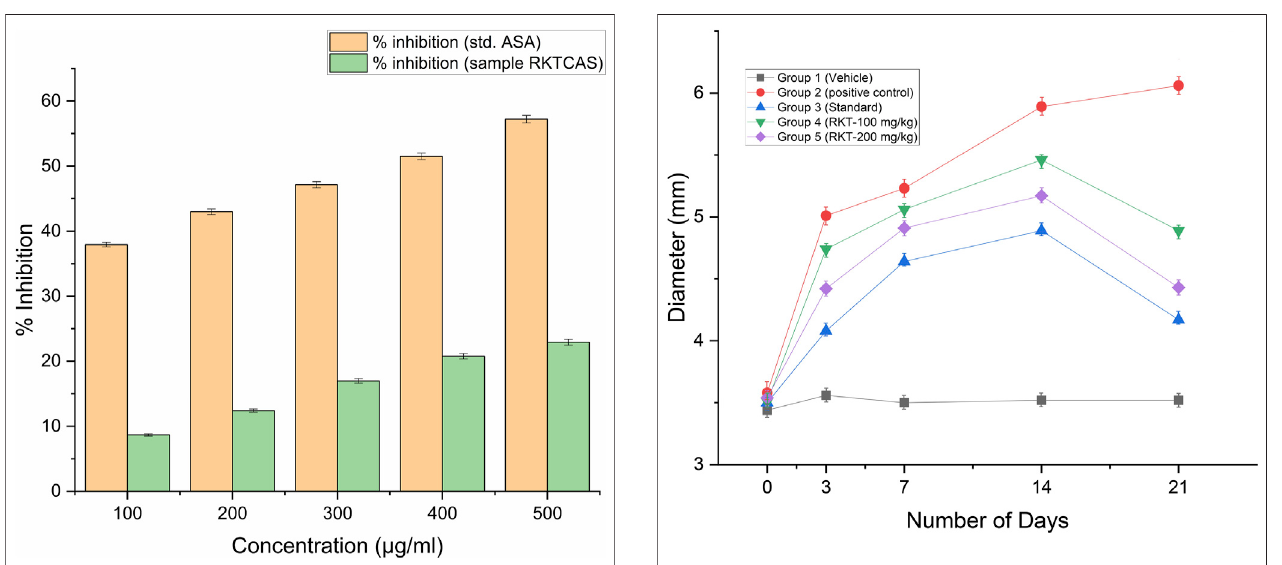
FIGURE 4 | In-vitro membrane stabilizing activity showing the possible mechanism of action for the anti-in fl ammatory activity of aqueous extract of Clerodendrum serratum L.